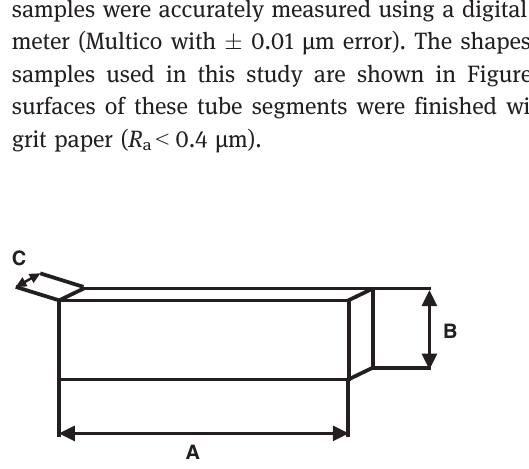
HR3C, TP347HFG; and one nickel-based alloy 718 þ . The chemical compositions of the alloys are shown in Table 1.